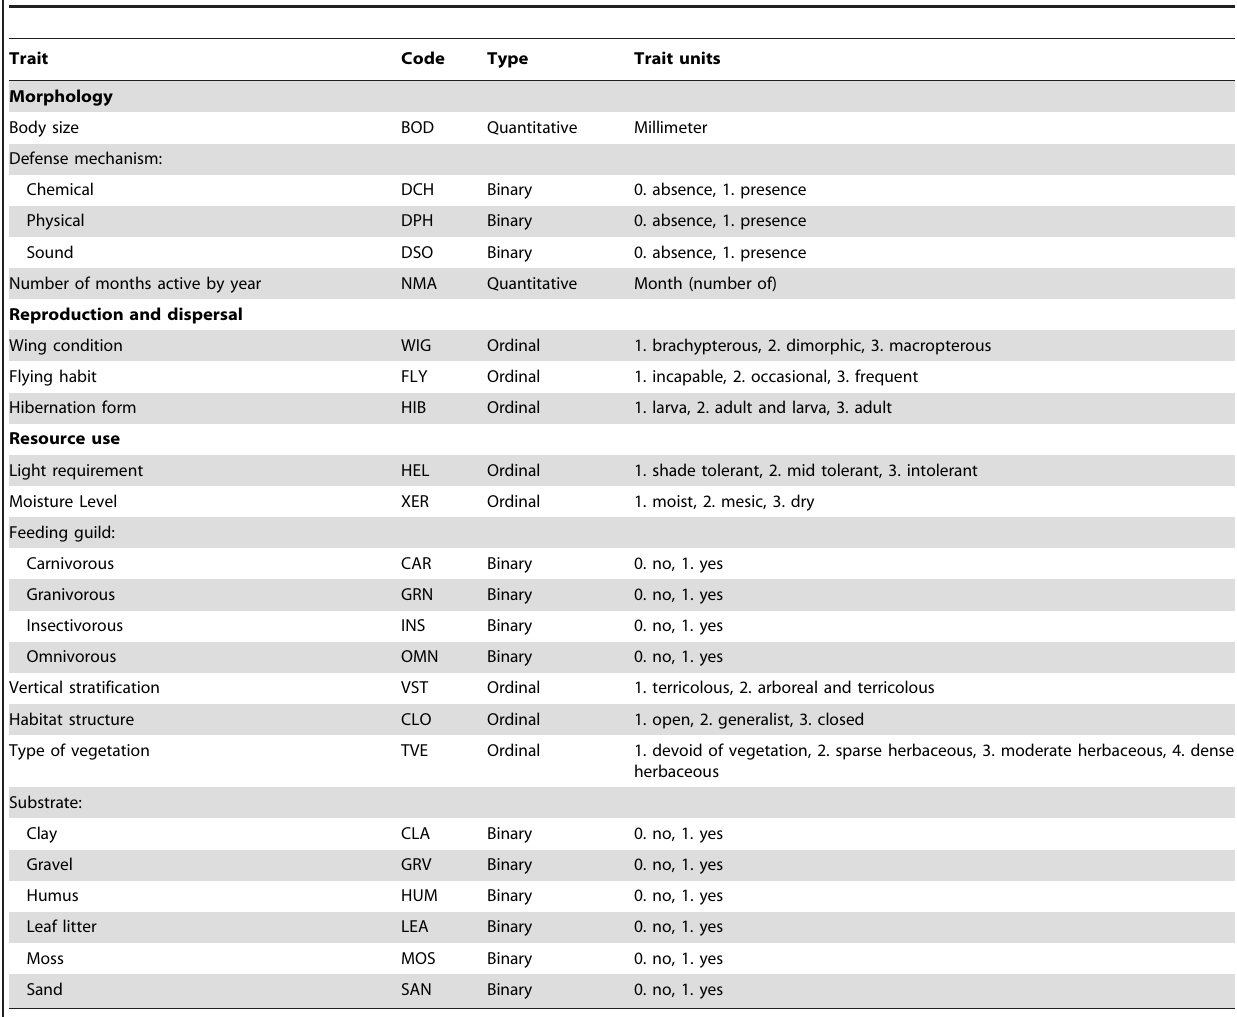
Table 2. Description and codes of ground beetle functional traits used in this